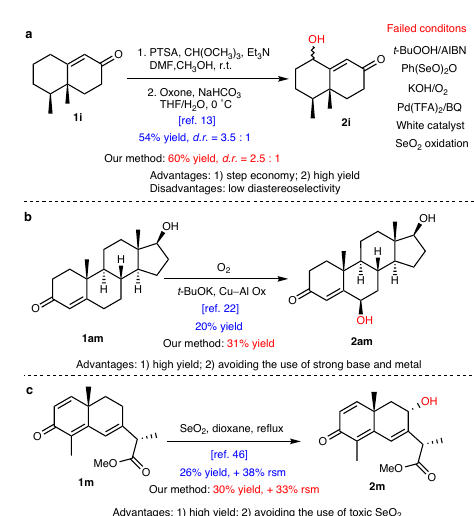
Fig. 6 | Comparation of our method with the published ones for the hydro- xylationofenones.a Thereportedmethodforhydroxylationof 1i . b Thereported method for hydroxylation of 1am . c The reported method for hydroxylation of 1m 46 . PTSA p-Toluenesulfonic acid. Cu-Al Ox copper – aluminum mixed